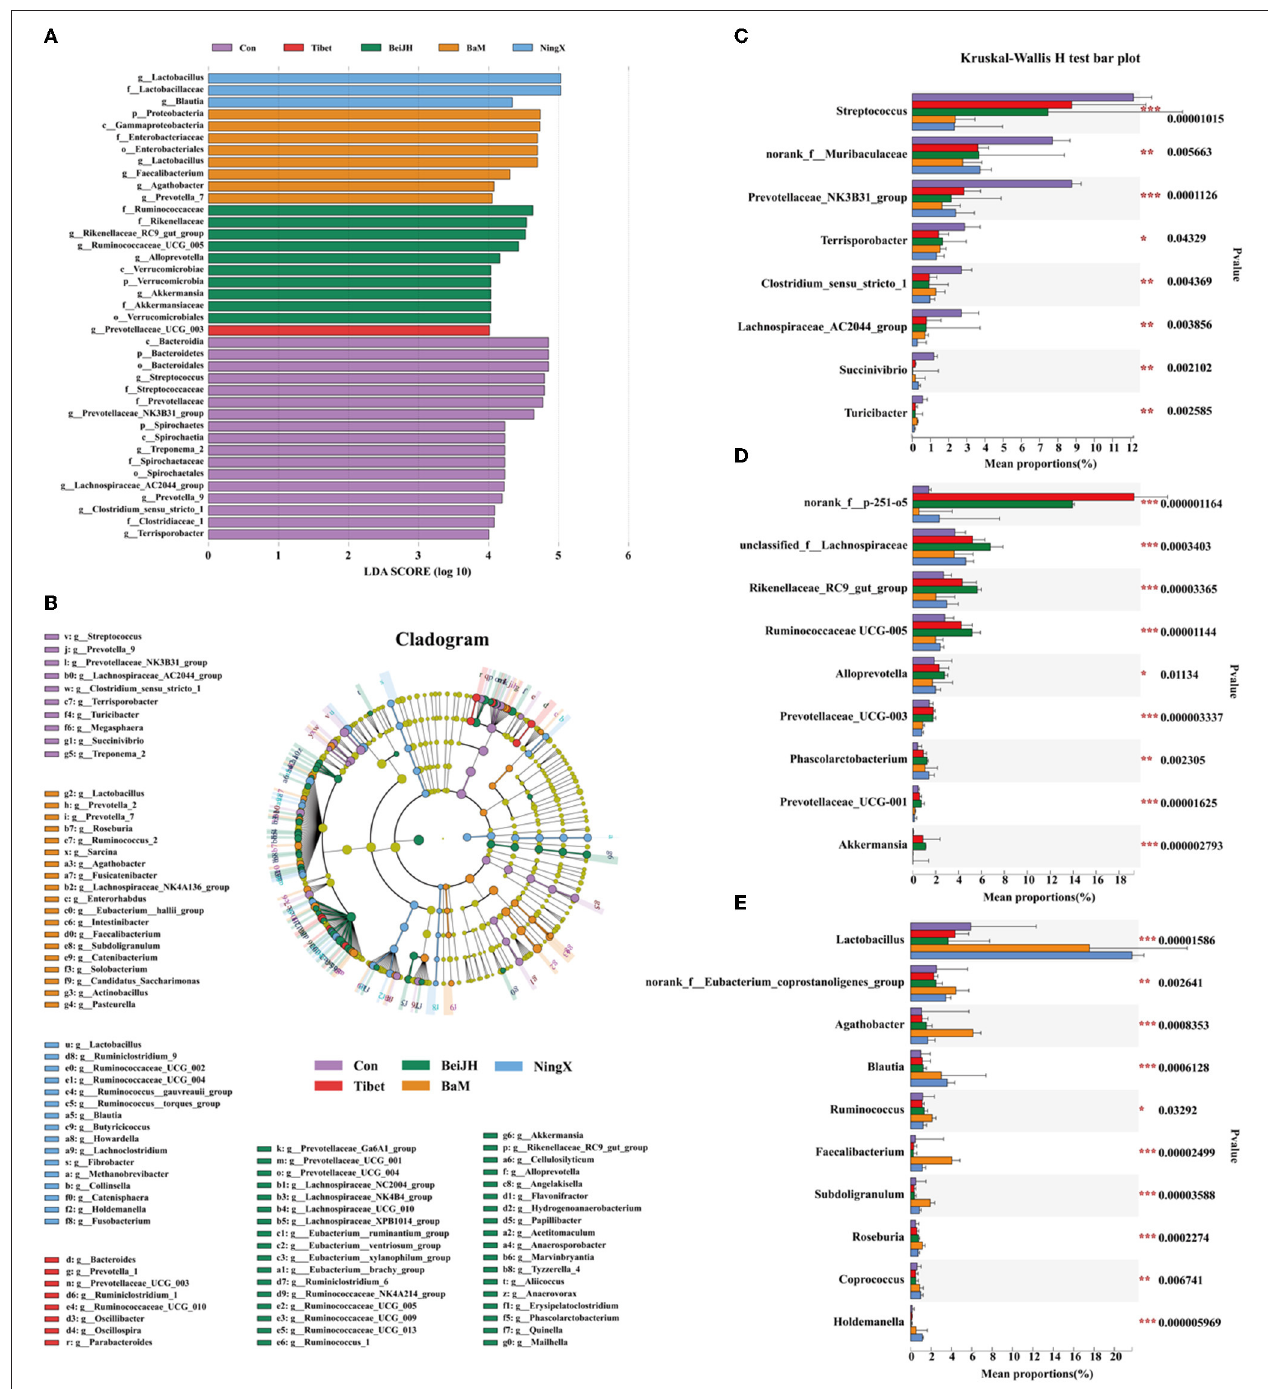
FIGURE 4 | Various breeds had significantly variant intestinal micro-environment. Histogram (A) and cladogram (B) of Linear Discriminant Analysis (LDA) value distribution by setting score 4 at genus level in LEfSe analysis. (C) Kruskal–Wallis H -test bar plot of bacteria that were abundant in Con group. (D) Kruskal–Wallis H -test bar plot of bacteria that significantly increased in both Tibet and BeiJH groups. (E) Bacteria that gained increased proportion in BaM and NingX groups. * P < 0.05; ** P < 0.01; *** P < 0.001.